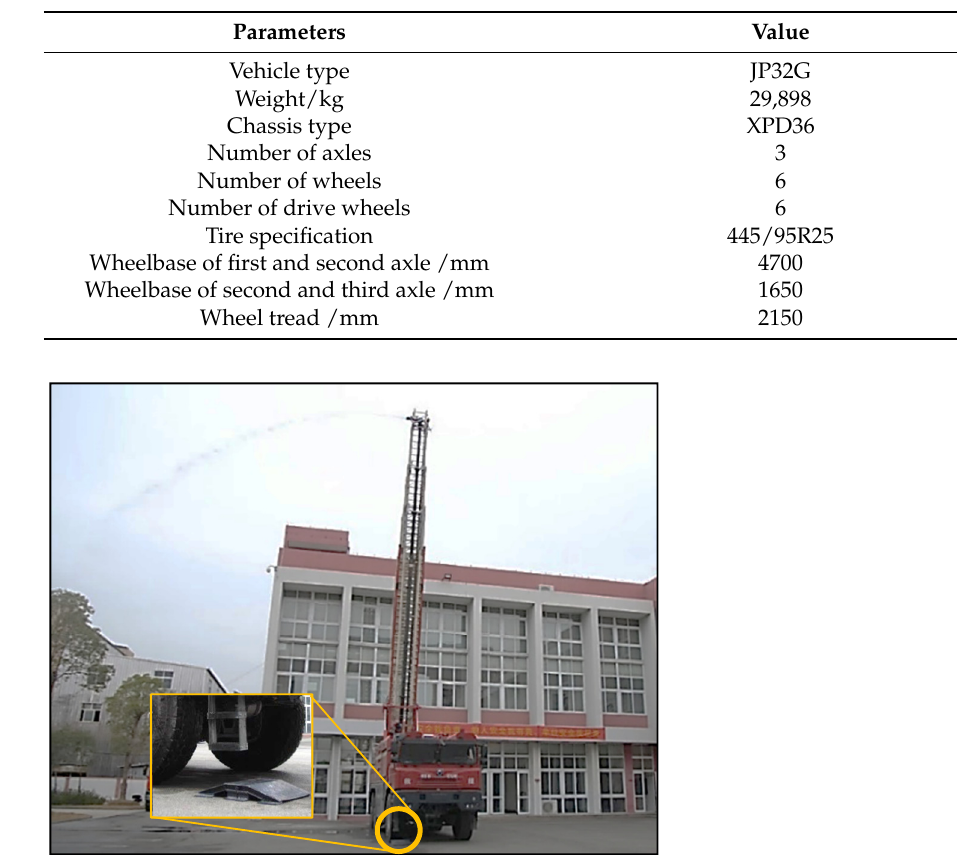
Figure 10. Structure of the integrated control system. Table 4. Main parameters of the tested vehicle.